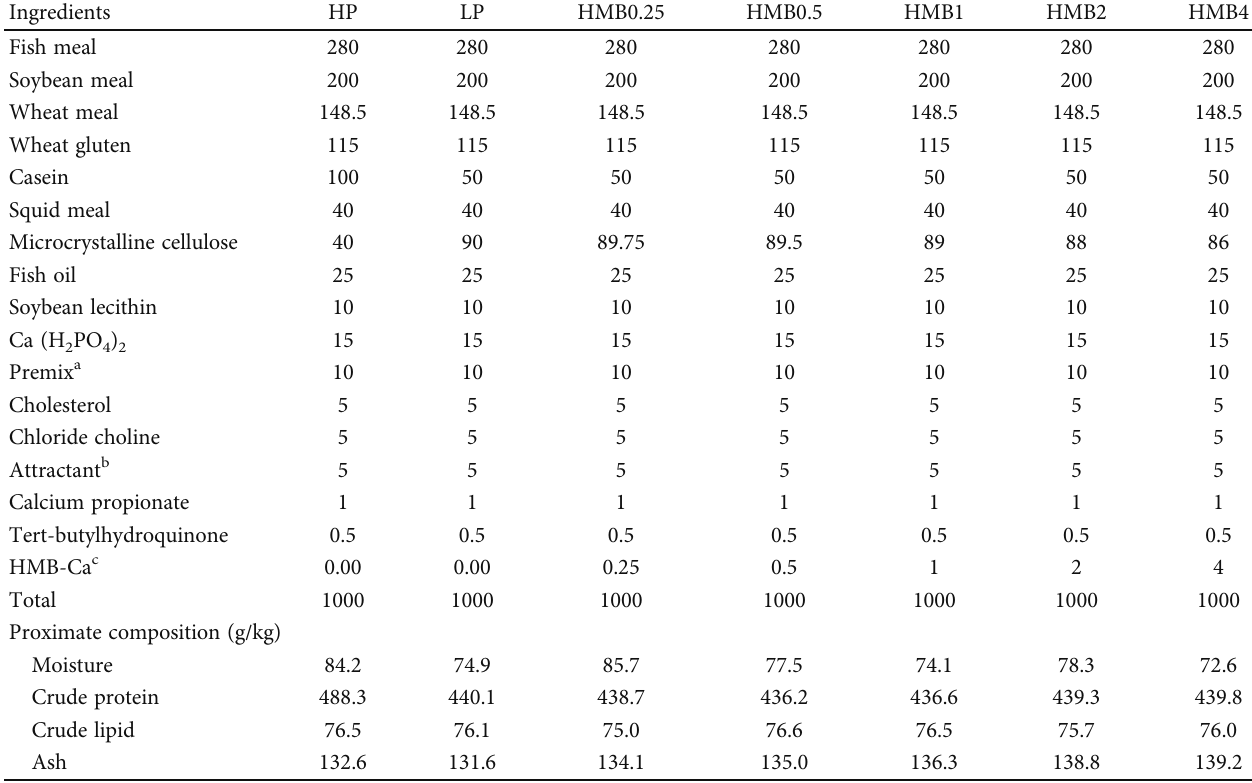
Table 1: Formulation and proximate composition of the experimental diets (g/kg dry